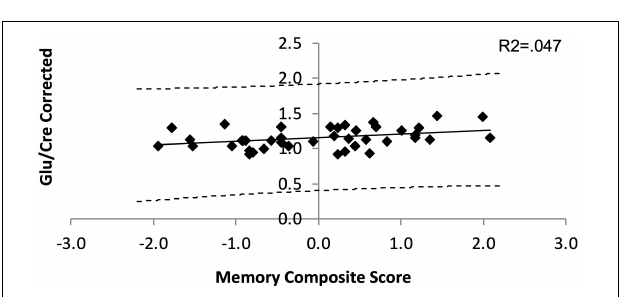
FIGURE 3 | Linear dependance of Glu/Cre on the Memory composite score. The solid line is the line of best fit in the linear regression model. The dashed lines represent the 95% confidence interval (CI) for the upper and lower bounds of the slope